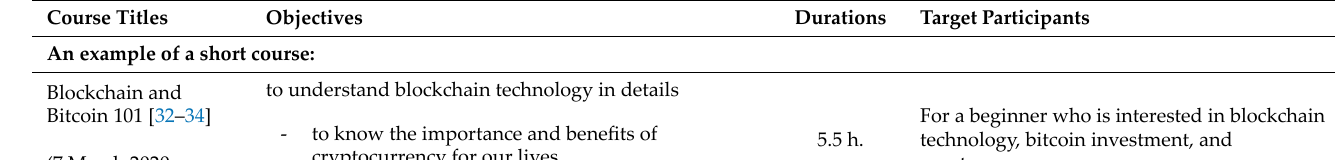
Table 4. Examples of courses based on duration